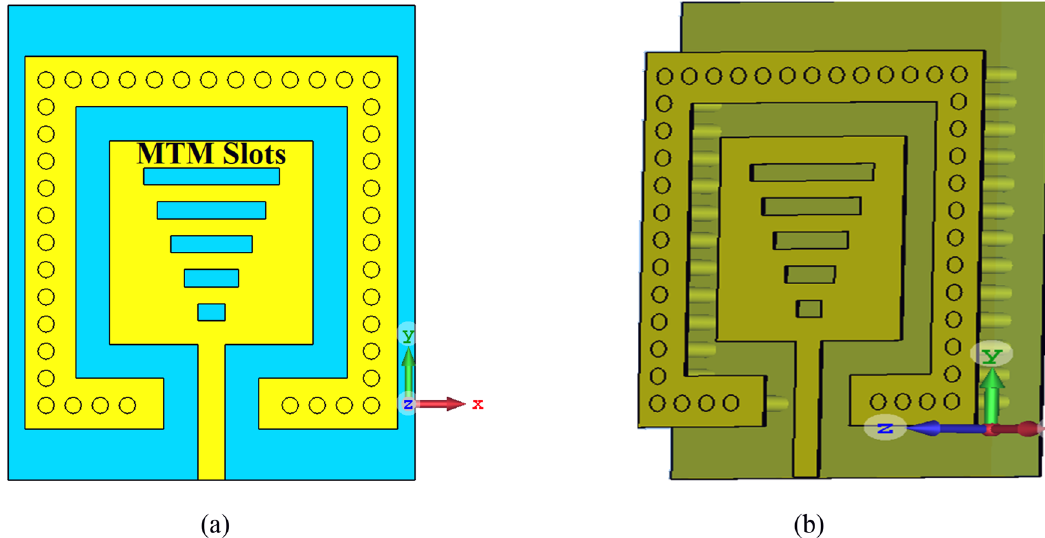
Figure 6. ( a ) front view, ( b ) schematic view of the SIW-loaded slotted antenna.